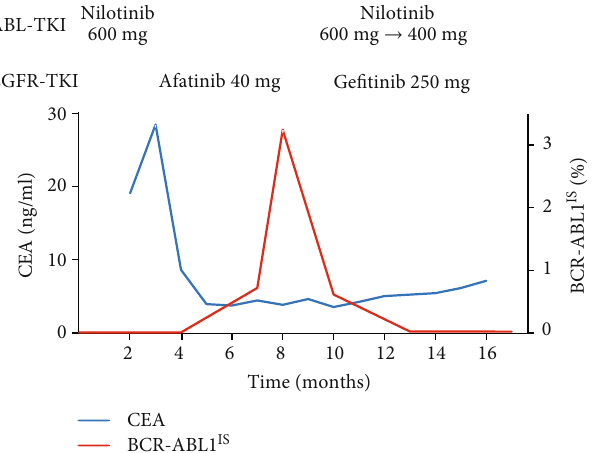
Figure 3: Serum CEA levels and BCR-ABL1 transcript levels on the international scale (BCR-ABL1 IS ) during the treatment.